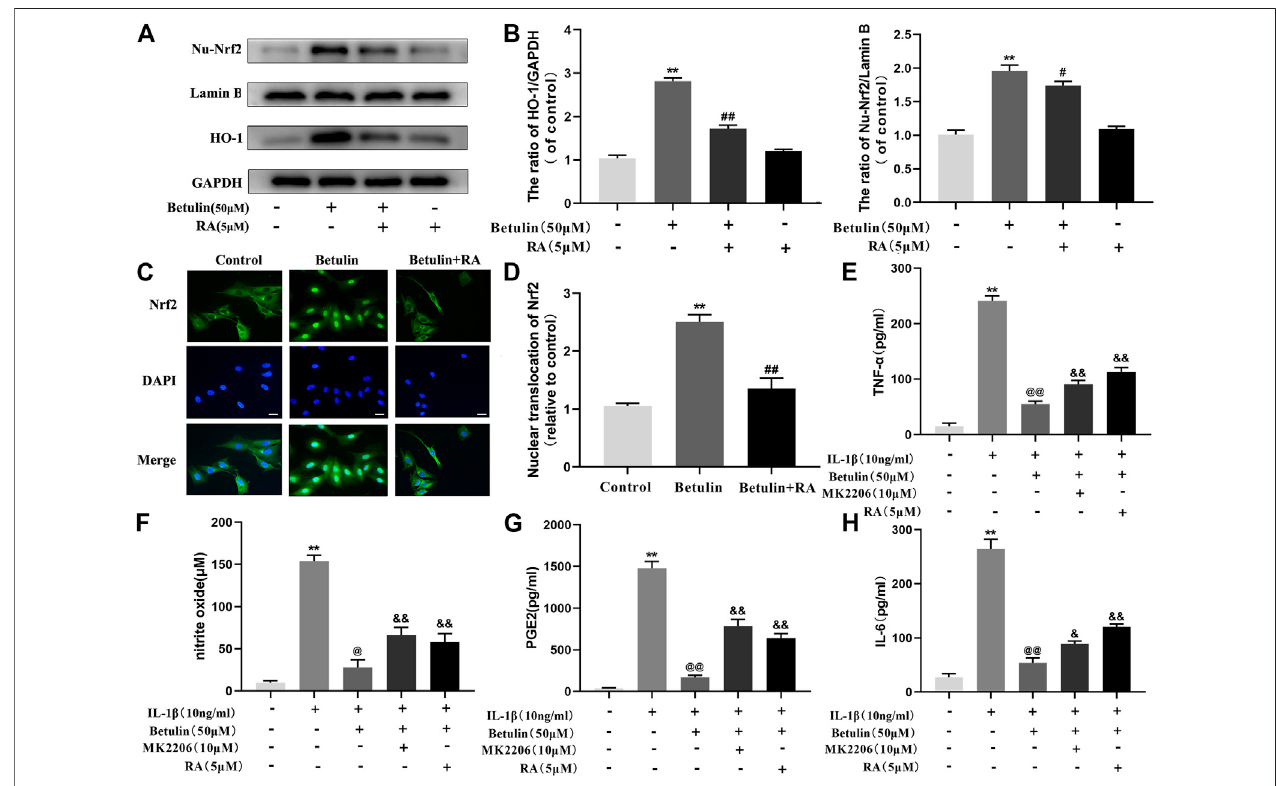
FIGURE7| BetulinupregulatestheexpressionofHO-1viaactivatingtheNrf2pathway.Thechondrocytesweretreatedwithretinoicacid(RA,5 μ M),aninhibitorof Nrf2, for 2 h and then treated with betulin (50 μ M) for 2 h. (A – B) The expression levels of Nu-Nrf2 and HO-1 in chondrocytes were detected by Western blotting and quantitatively analyzed. (C – D) Immuno fl uorescence staining combined with DAPI staining (scale: 25 μ m) were used to detect the entry of Nrf2 into the nucleus and quantitatively analyzed. (E – H) The protein levels ofTNF- α , IL-6, and PGE2 were measured by the commercial ELISA kits, and the generation ofNO wasmeasured by Griess reaction. The data in the fi gure show thatthe averagevalue is ± SD, ** p < 0.01 compared with the control group, ## p < 0.01 compared with the Betulin-treated group, && p < 0.01 compared with the Betulin + IL-1 β – treated group, @ p < 0.05 compared with the IL-1 β group, n (cid:2) 3.